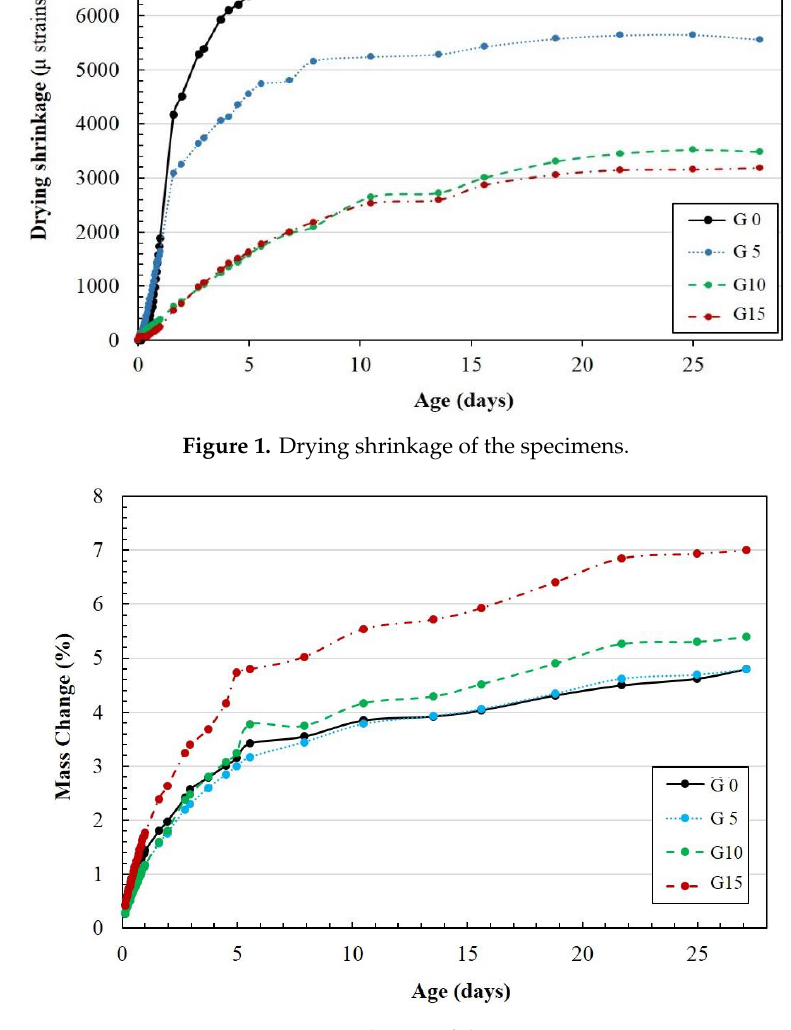
Figure 2. Mass change of the specimens.